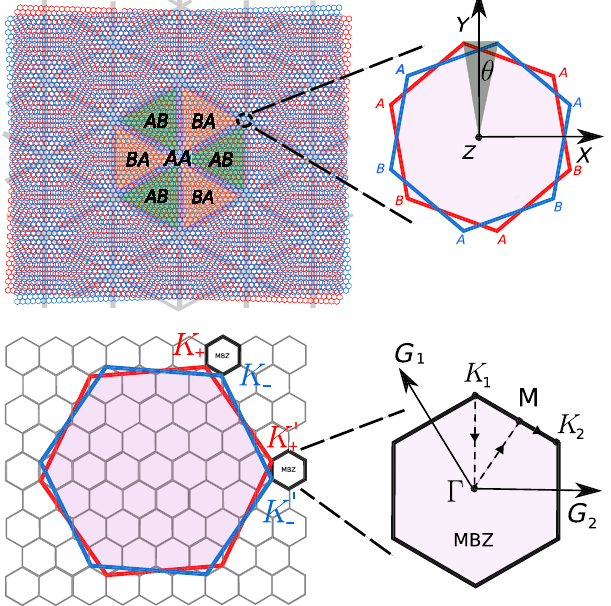
FIG. 1. Top: Moir´e superlattice formed by two unrelaxed graphene layers (in blue and red) twisted by an angle θ . We indicate the different stacking regions: AA and the two different Bernal regions AB and BA . The domain walls (DWs) separate AB from BA regions and connect different AA regions. On the right, an enlargement of the AA stacked region is shown: two over- lapping hexagons in distinct graphene layers are rotated in opposite directions around the perpendicular z axis by an angle θ = 2 . Bottom: The folding procedure in TBLG. The original single-layer Brillouin zones (in red and blue) are folded into the mini Brillouin zone (MBZ). Two inequivalent K points in different layers ( K − and K 0 þ or K 0 − and K þ ) are folded into the same points, K 1 or K 2 , of the MBZ. The path K 1 → Γ → M → K 2 is also